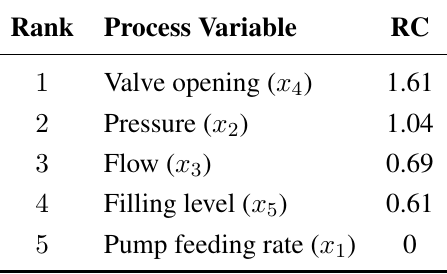
Table 4. Root cause priority list calculated from the causal matrix in Figure